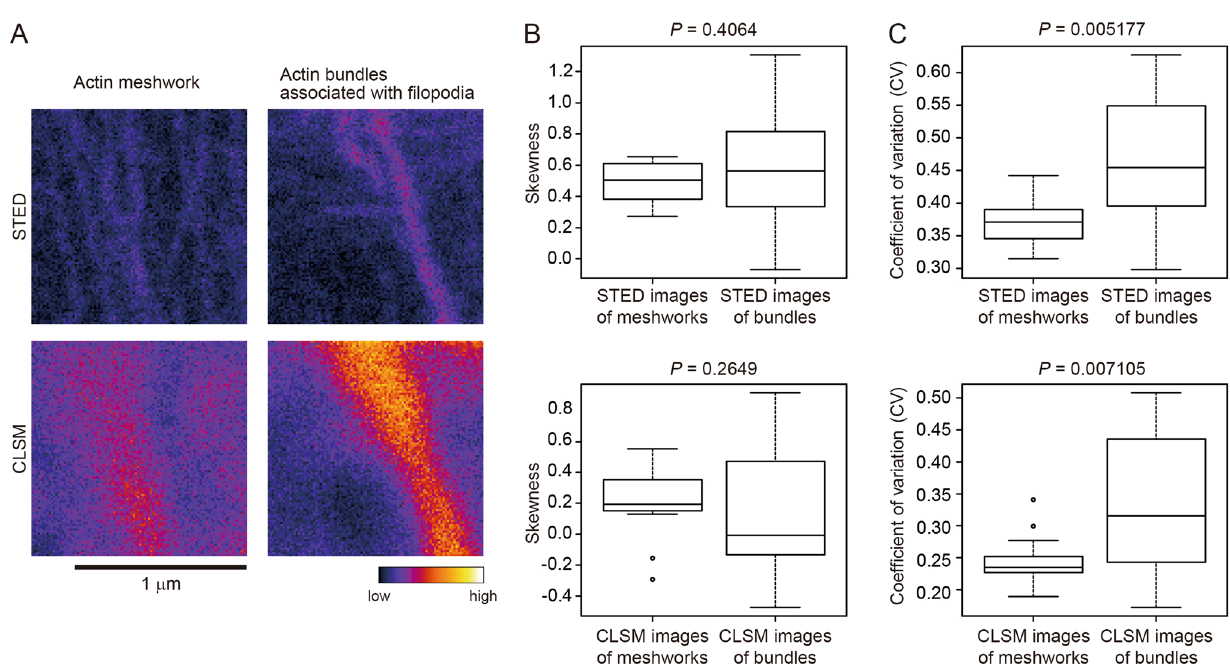
Figure 7. Evaluation of actin filament bundling in STED and CLSM images. ( A ) Representative stimulated emission depletion microscopy (STED) and confocal laser scanning microscopy (CLSM) images of the same regions of TRITC-phalloidin-labeled actin filaments in NG108-15 cells. The actin meshwork and actin filament bundles associated with filopodia are shown. Scale bar indicates 1 μm. ( B ) Skewness of the intensity distribution. ( C ) CV of the intensity distribution. Significance was determined using the Mann–Whitney U-test. N =